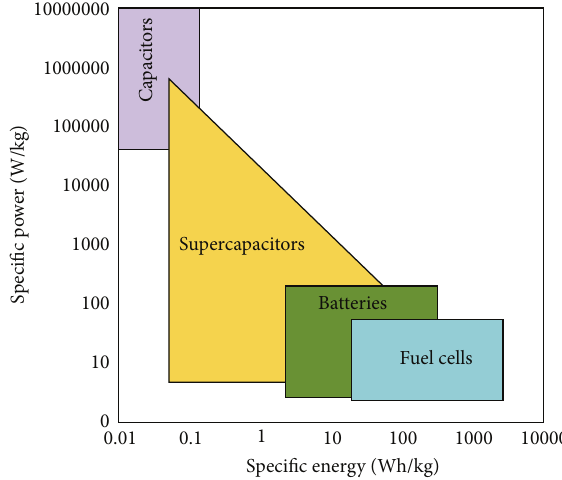
Figure 1: Power and energy density of FC, batteries, and capacitors